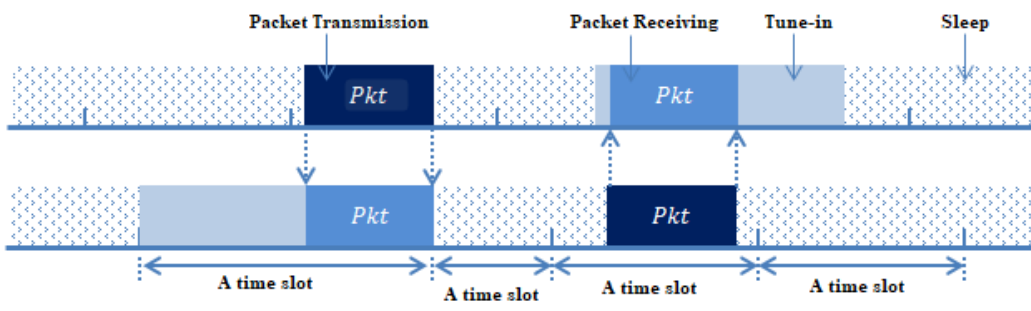
Figure 1. Overview of the proposed